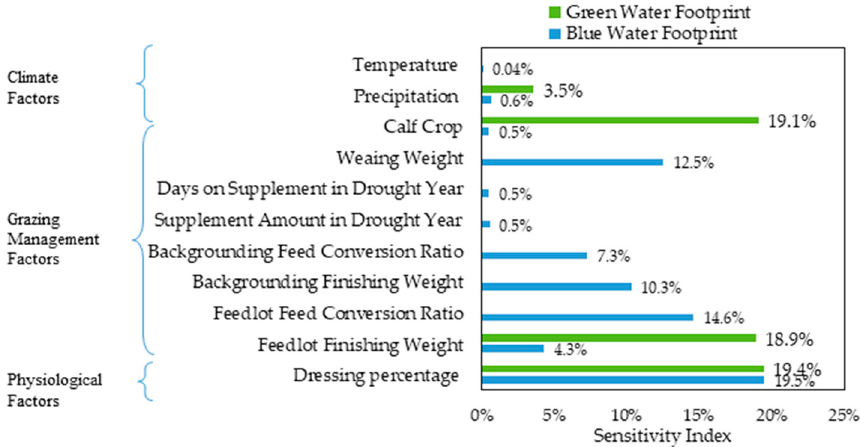
Figure 3. Sensitivity of estimates of blue water footprint of beef production in New Mexico to a 10% change in the model input parameters values.